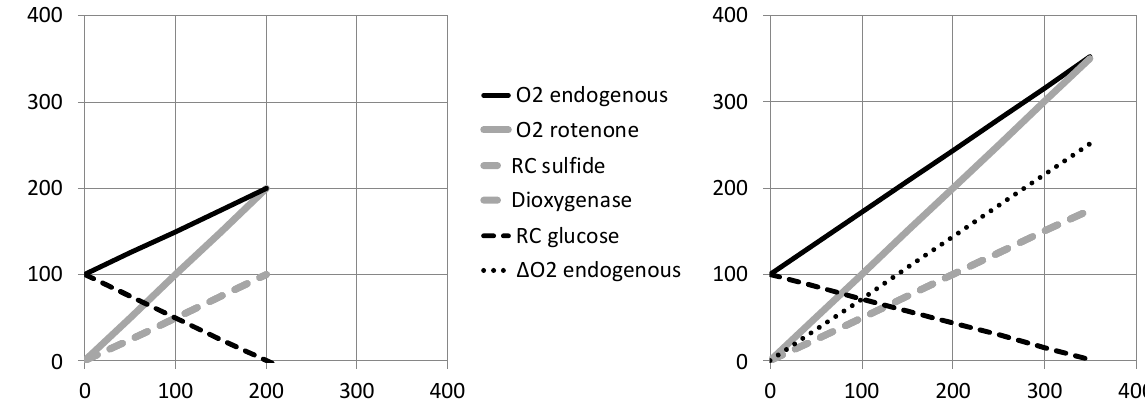
Figure 8. Impact of sulfide oxidation on cellular oxygen consumption. The X-axis sulfide infusion rate, Y-axis oxygen consumption rate represented with the same units: moles/(time × volume). Endogenous respiration is supposed to be fed by glucose with a value of 100 at the origin of the X-axis (sulfide infusion = 0). Sulfide infusion is then increased to the point where all electrons in the respiratory chain come from sulfide, hence when oxygen consumption caused by glucose oxidation is lowered to zero: “RC glucose” (dashed black line). The oxygen consumption rate for sulfide oxidation into thiosulfate is the sum of respiratory chain “RC sulfide” and of “Dioxygenase” contribution that are equal (dashed gray line). Their sum therefore predicts the increase in O 2 consumption rate if endogenous cellular respiration is poisoned by rotenone: “O 2 rotenone” (solid gray line). The sum “RC sulfide + Dioxygenase + RC glucose” predicts the cellular oxygen consumption rate in the presence of endogenous respiration: “O 2 endogenous” (solid black line). The impact of sulfide oxidation on glucose oxidation is shown with two different models: ( Left ) if electrons from SQR simply replace those coming from carbon oxidation. ( Right ) If a constant ATP turnover is maintained, which implies correction for the different ATP/O 2 yields of glucose (5.7) and sulfide (1.6), the dotted black line, “ ∆ O 2 endogenous,” highlights that with this model, the increase in oxygen consumption caused by sulfide in the presence of endogenous respiration represents more than the contribution of the dioxygenase.